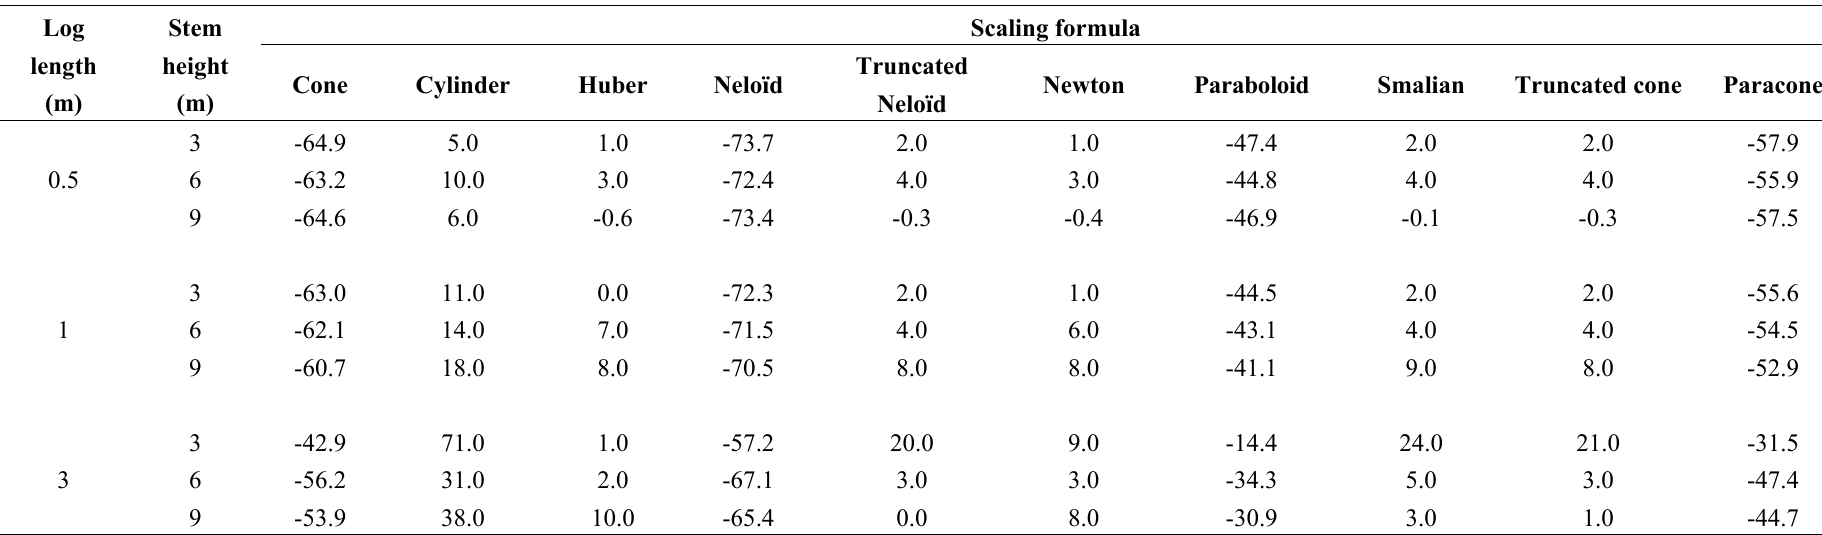
Table 4. Mean values of the systematic error (SE) by sampling height and length of the logs for different methods of scaling. Log length height (m)